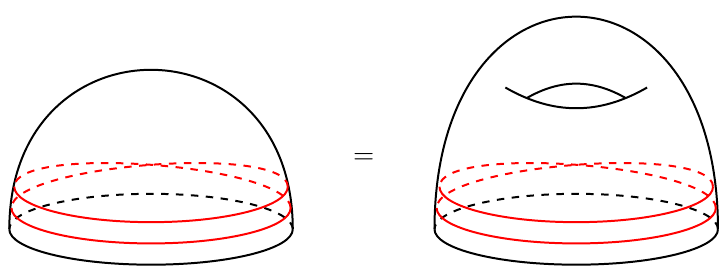
Figure 7 . The indistinguishability of different bulk manifolds. Since the red worldline stays close to the boundary, different topologies are not distinguishable for